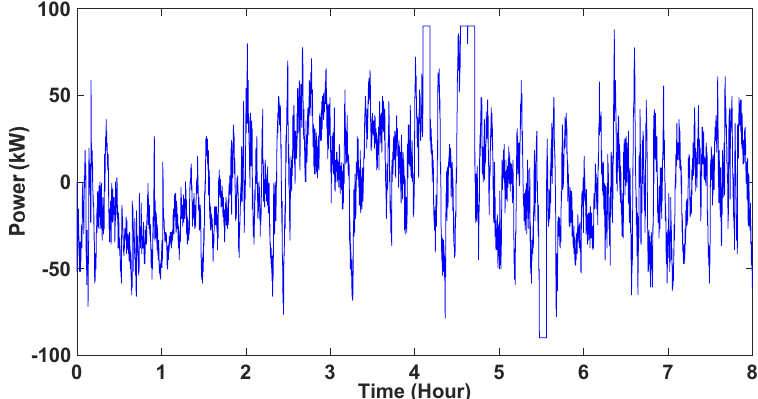
Figure 6. Eight-hour UK grid service profile to be used in the COF.